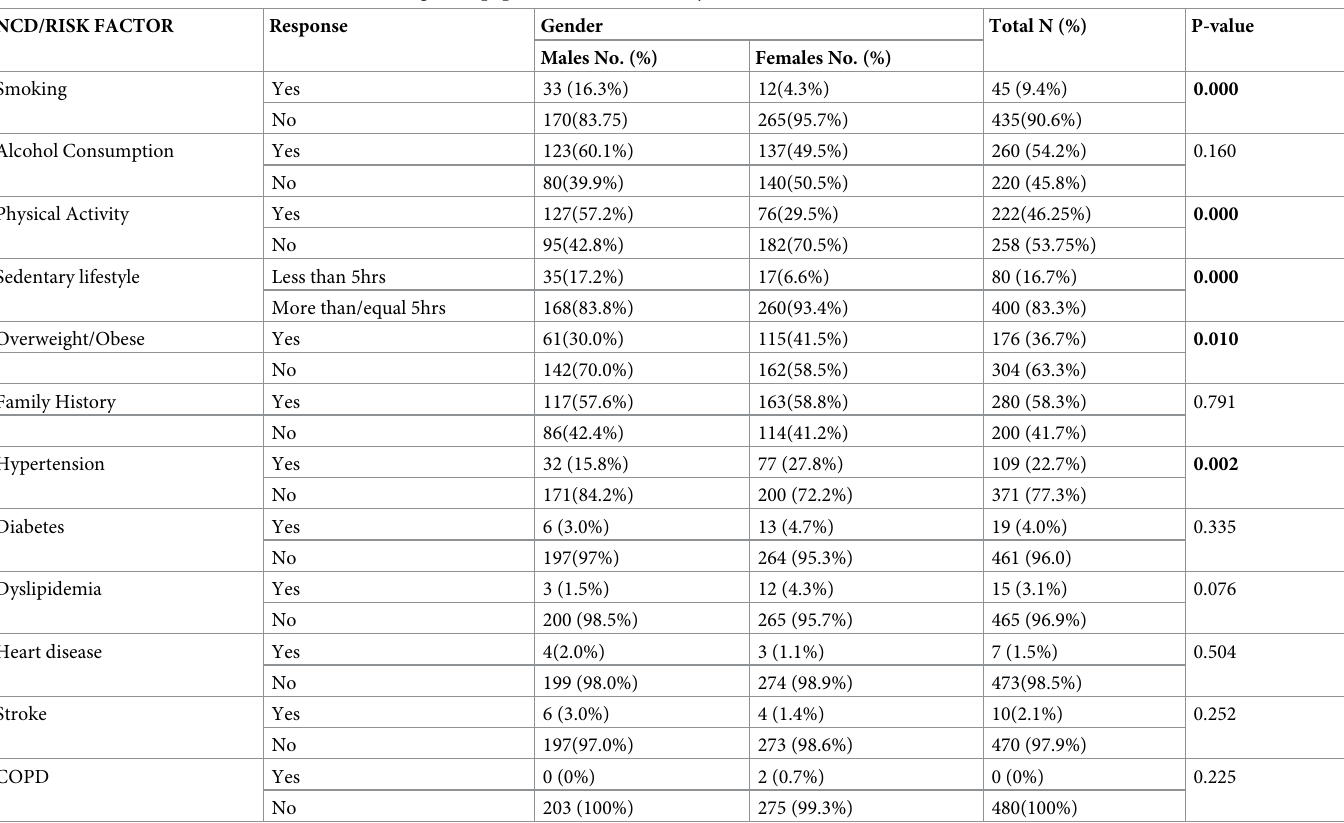
Table 2. Prevalence of NCDs and risk factors among adult population in LEKMAH by sex (n = 480).